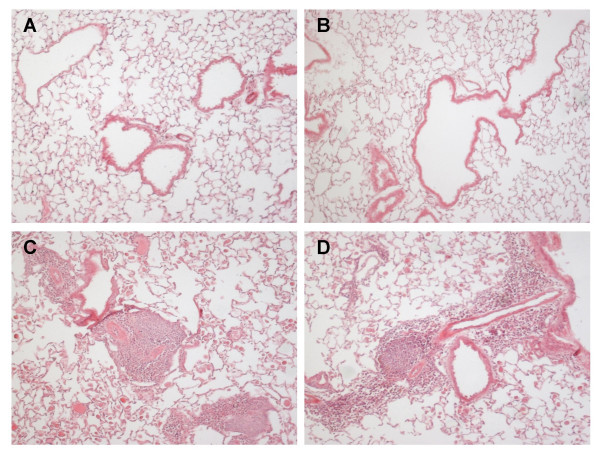
Representative histological sections (hematoxylin and eosin stained) from healthy control animals in the PBS'98 group (picture A and B) and from animals having undergone a 98-day ovalbumin challenge protocol, the OVA'98 group (picture C and D). Examination of sections from OVA'98 animals revealed a significant inflammation surrounding the airways and within the alveolar spaces. PBS'98 did not show any signs of inflammation.